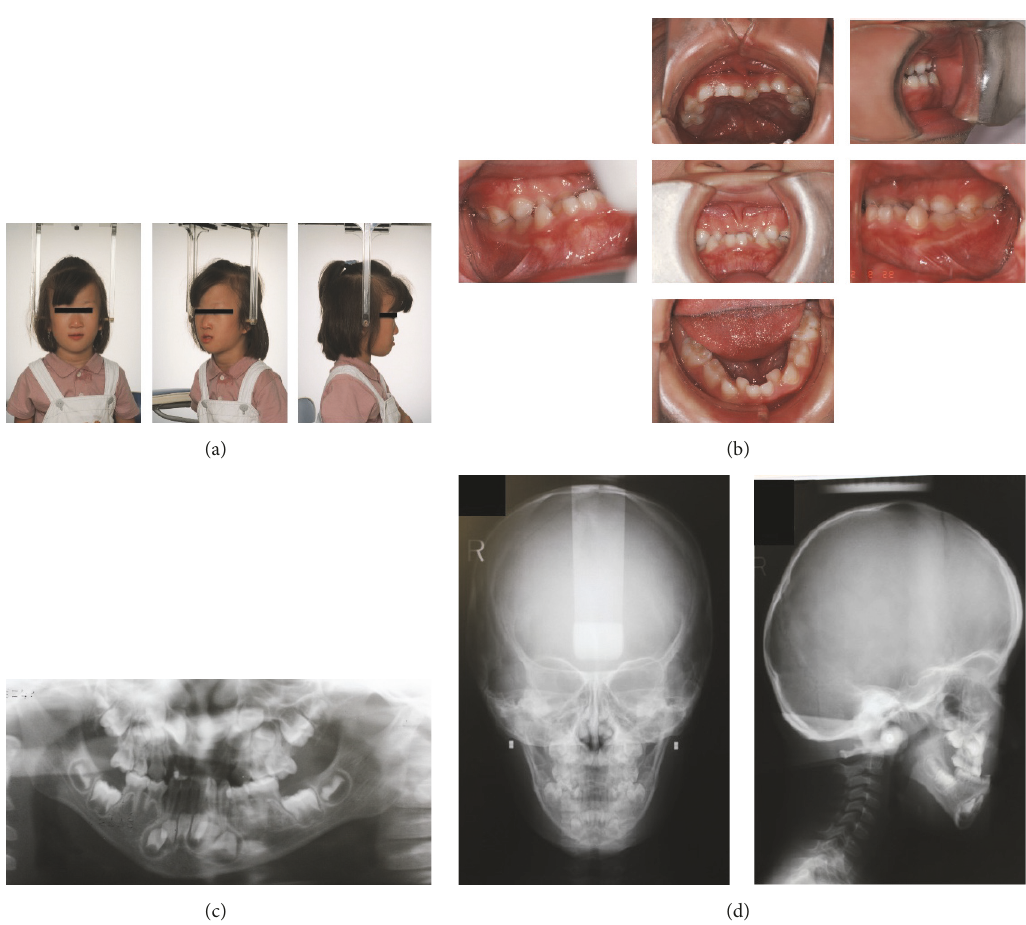
Figure 1: Pretreatment photographs (5 years and 1 month). (a) Extraoral photographs. (b) Intraoral photographs. (c) Orthopantomograms. (d) Posteroanterior and lateral